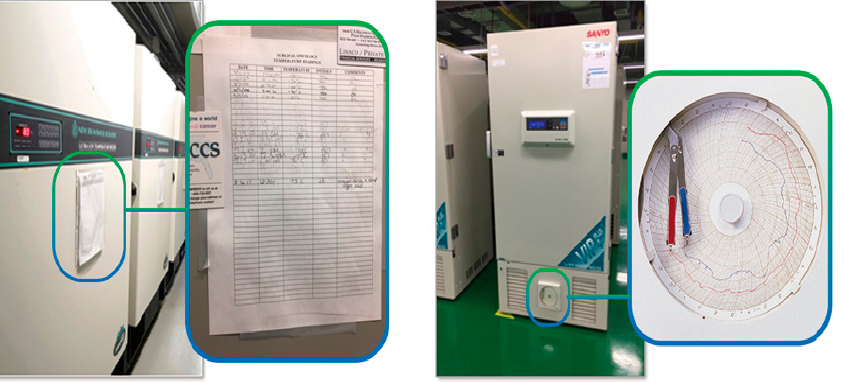
Figure 1. General status of monitoring small-scale cryogenic freezers .